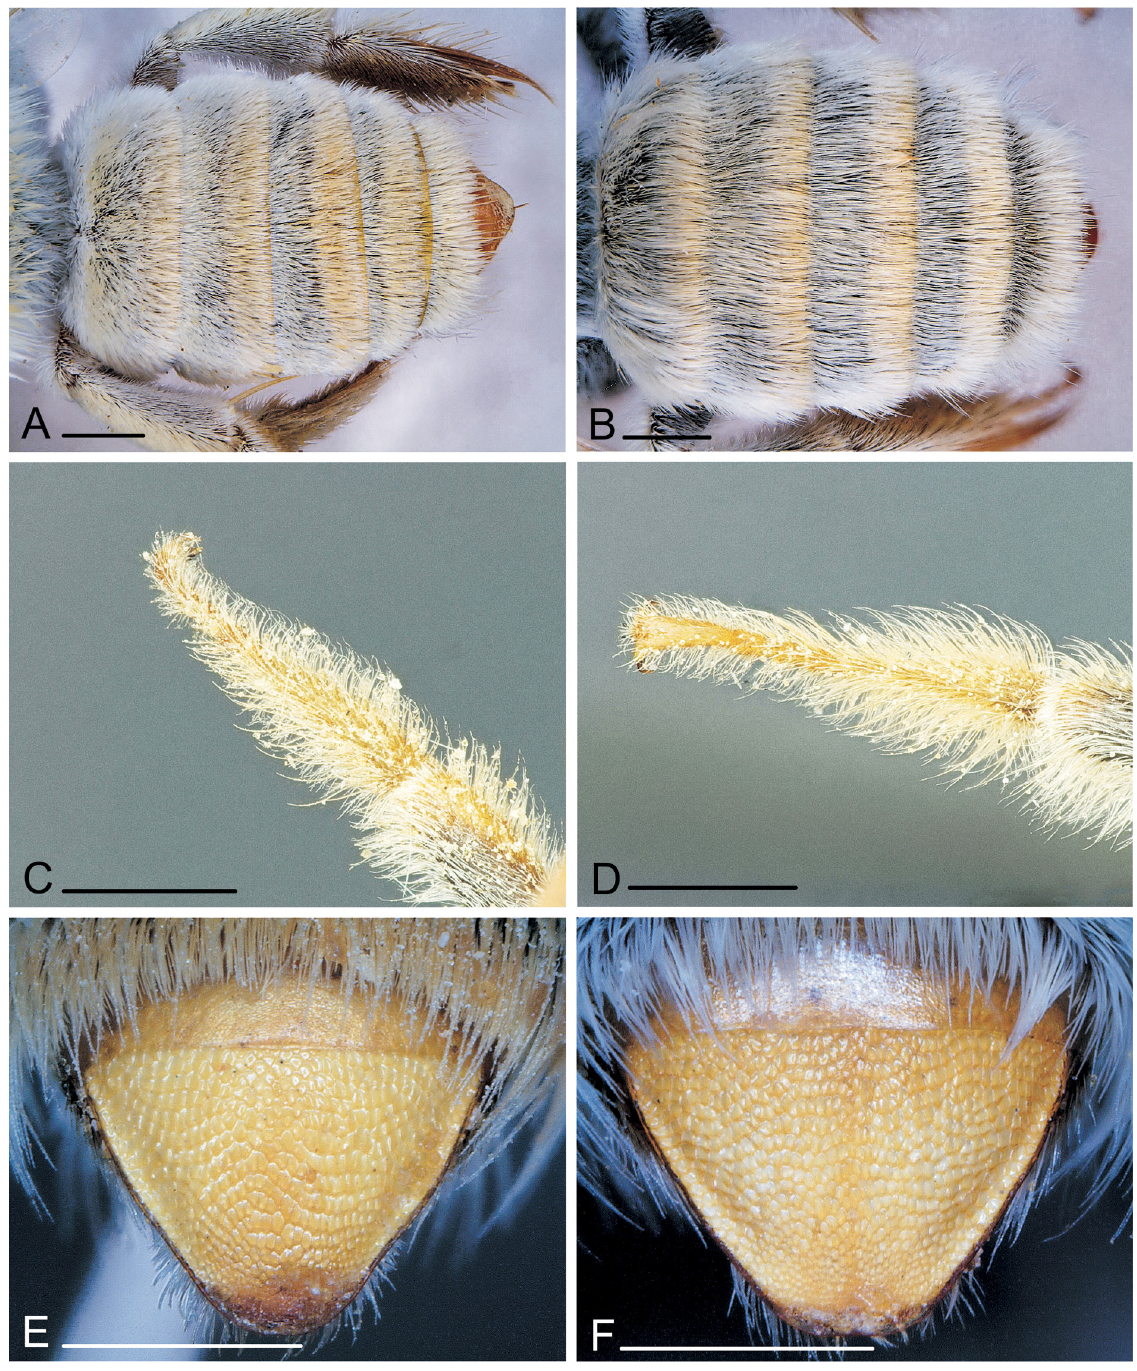
Fig. 1. Fidelia spp., ♀♀. A , C , E . Fidelia whiteheadi Litman & Kuhlmann sp. nov. (paratype). B , D , F . F. hessei Whitehead & Eardley, 2003. A – B . Metasoma. C–D . Forebasitarsus. E–F . Pygidial plate. Scale bars: 1